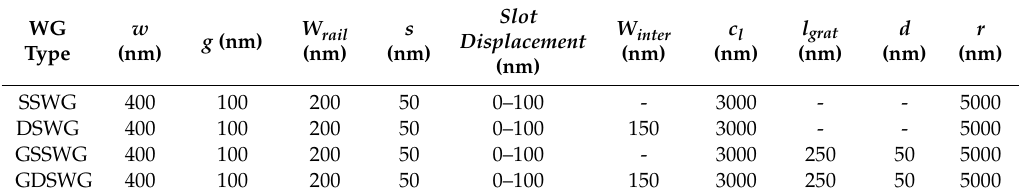
Figure 6. Schematic of race track resonator based on ( a ) SSWG, (b) DSWG, ( c ) GSSWG, ( d ) GDSWG. Table 2. Race track resonator parameters.